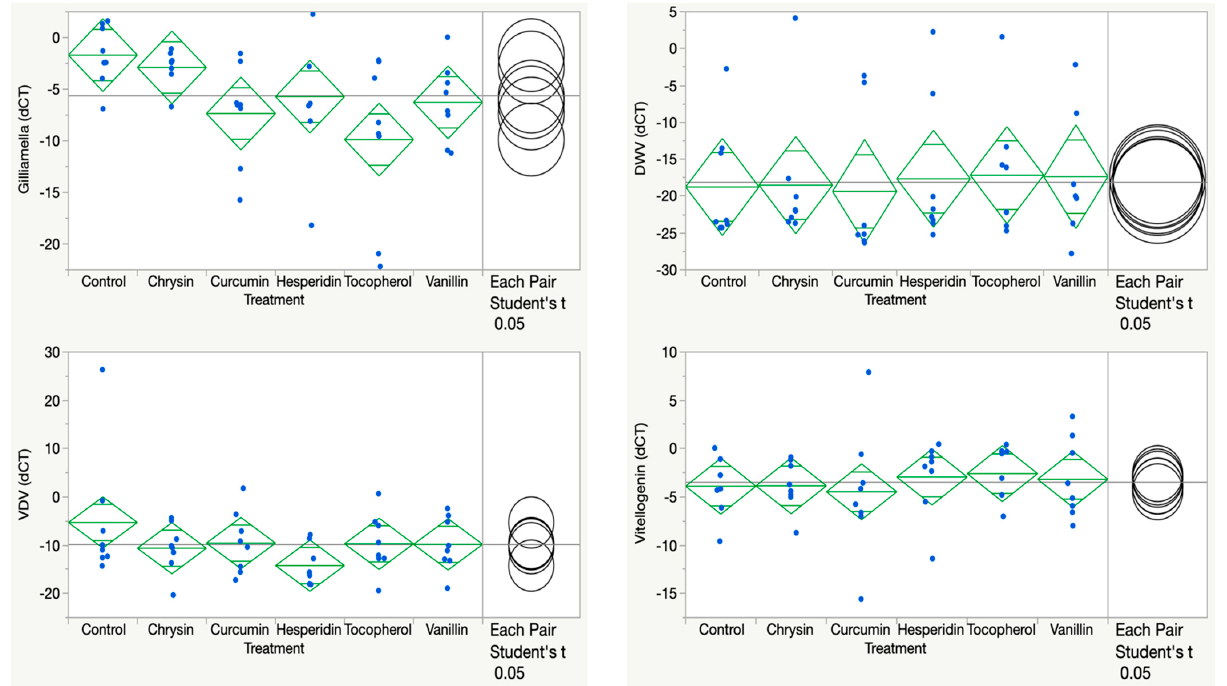
Figure 1. One-way analysis of viral/bacterial loads and vitellogenin by treatment. Normalized Cq values of two honey bee viruses, DWV and VDV, the honey bee gut bacterial symbiont, Gilliamella , and transcripts for the storage protein vitellogenin. Treatments were supplemented at 100 ppm in sugar syrup. The diamond tips represent the 95% confidence intervals for the ANOVA, with the mean designated with the middle horizontal line across each diamond. Comparison circles shown the means, where circles that overlap are not significantly different, whereas circles that do not overlap are significantly